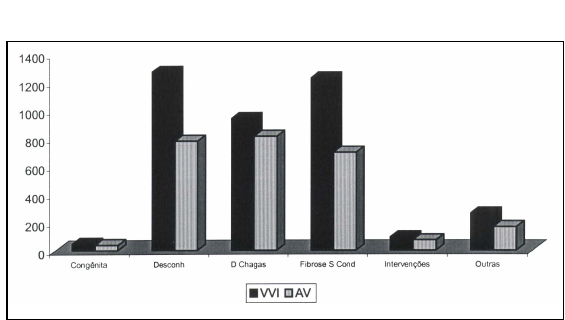
Fig. 10 - Modos de estimulação utilizados nos implantes iniciais, agrupados segundo a etiologia do distúrbio da condução dos